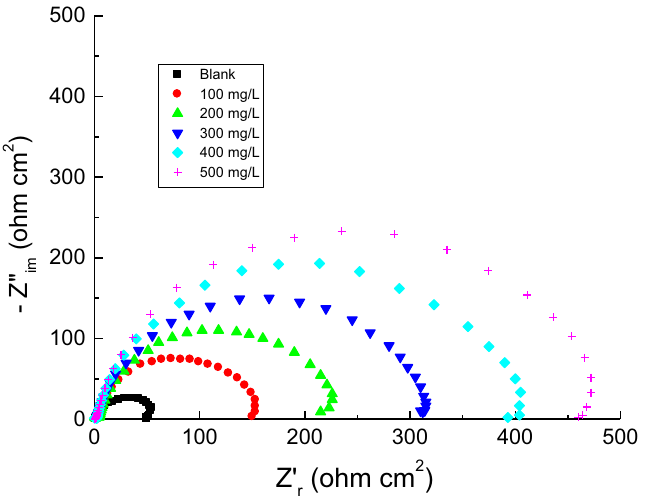
Figure 8. Nyquist plots representing the copper corrosion in 1.0 M H 2 SO 4 solution and in the presence of the surfactant TS at 298 K.